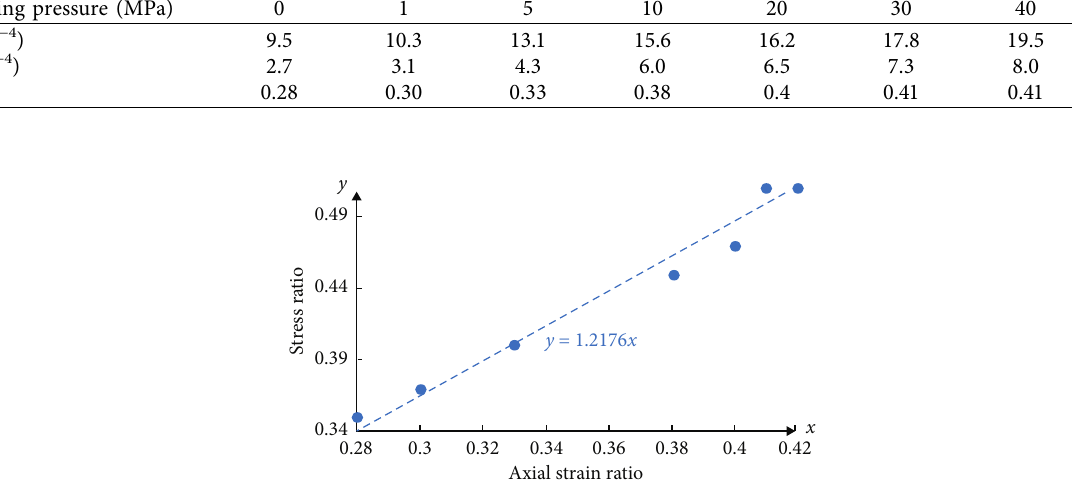
Figure 13: Stress ratio versus axial strain ratio curve.